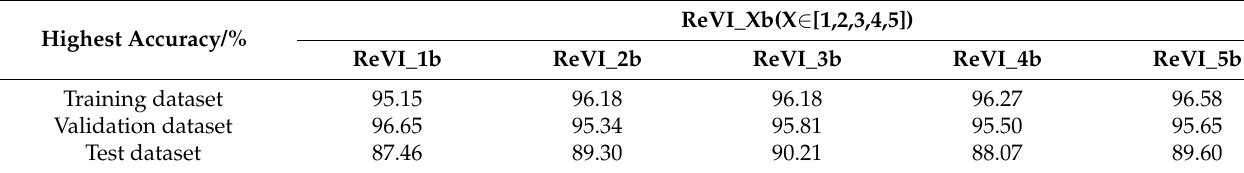
Table 2. ReVI tuning model